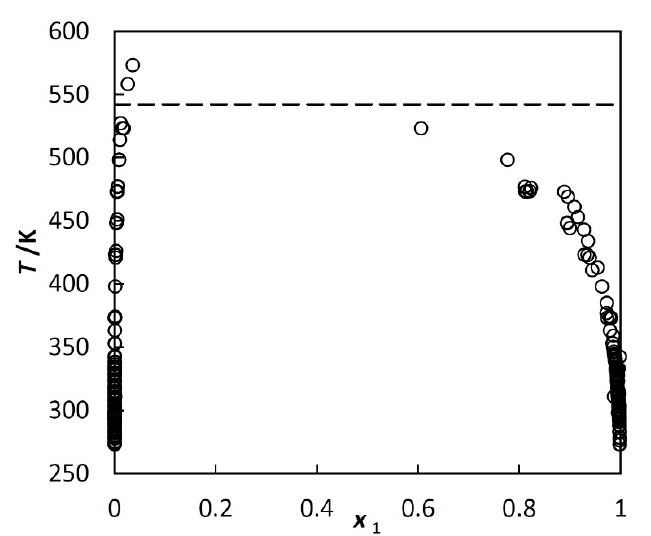
Figure 1. Liquid-liquid equilibrium in benzene (1) + water (2) system under saturated vapor pressure; experimental mole fractions of benzene at various temperatures taken from different literature sources. Dashed line corresponds to the three-phase critical temperature. Figure 1 is typical for systems investigated in this paper. The two liquids and vapor exist up to the three-phase critical temperature, T 3c . At T 3c , hydrocarbon-rich phase disap- pears, but water saturated with the hydrocarbon and the vapor still exists. The